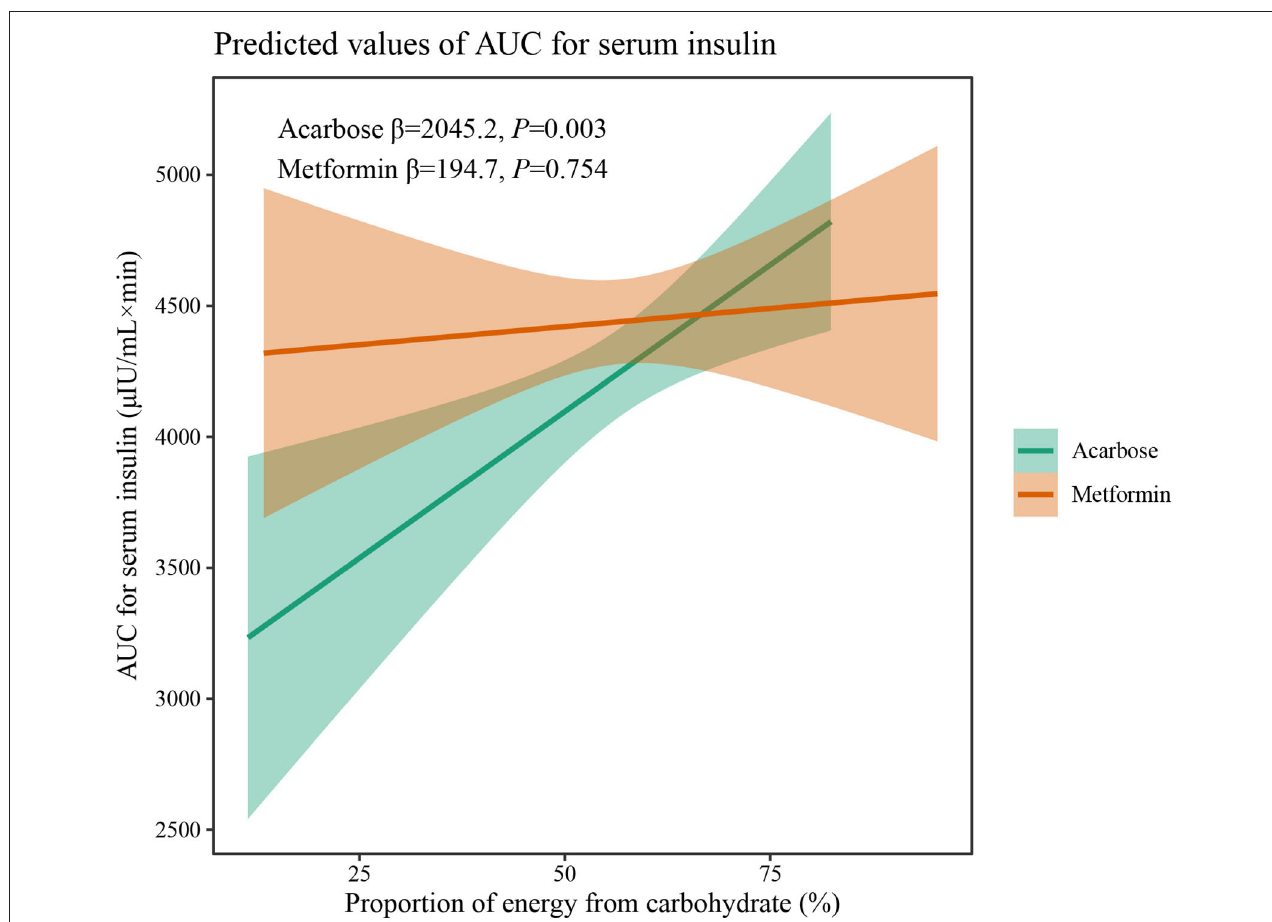
FIGURE 5 | Differential associations between proportion of energy from carbohydrate intake and AUC for serum insulin in metformin and acarbose groups. The β value adjusted for age, sex, time of intervention, and duration of